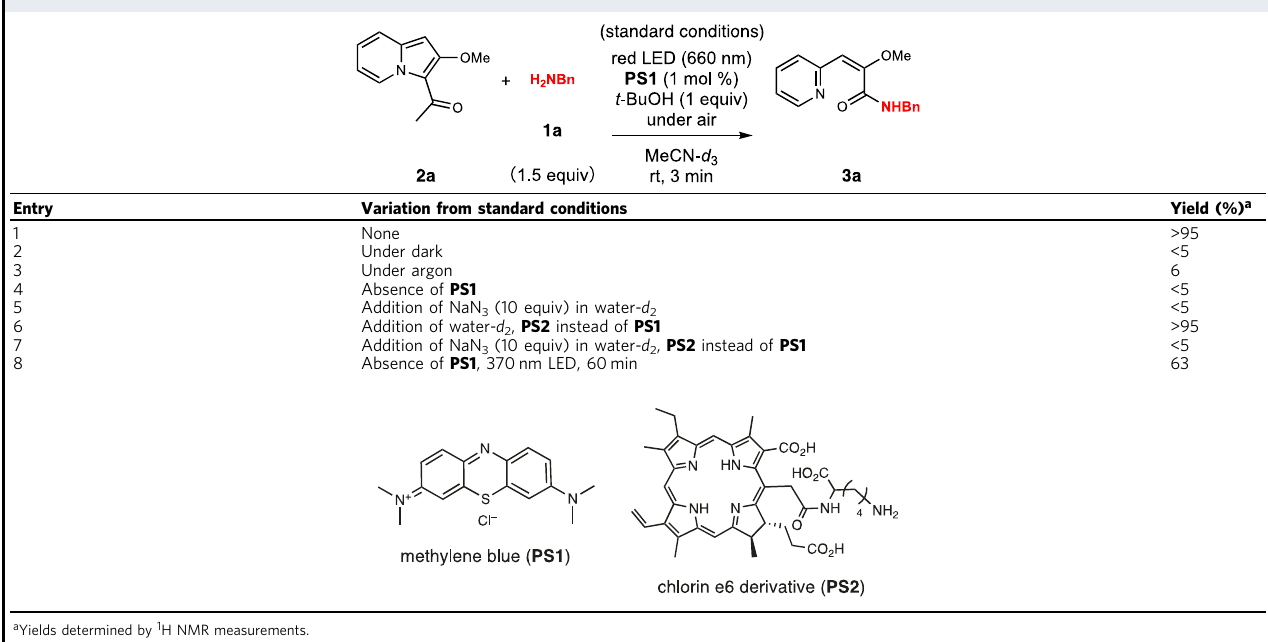
Table 2 Control experiments.